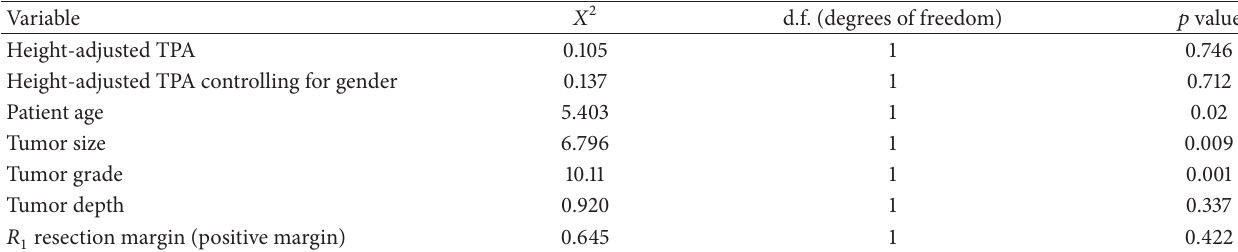
Table 3: Results of Cox proportional hazard model for height-adjusted total psoas area (TPA) and overall survival. Variable Height-adjusted TPA